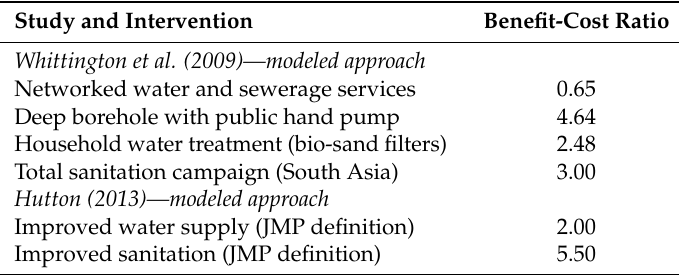
Table 7. Benefit-Cost Ratios from Global